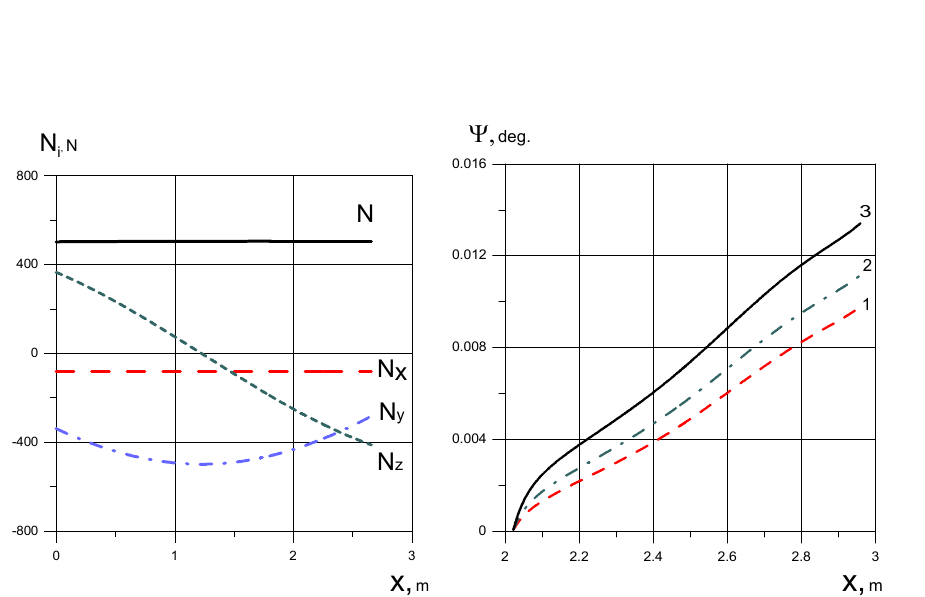
Figure 8 – Calculated values of the reaction force of the screw groove N and its projections on the axes of the starting coordinate system, as well as the yaw velocity angle Ψ along the length x of the spatial movement of the projectile at different elevation angles θ 0 of the tubular guide: 1 – θ 0 =19 0 4’; 2 – θ 0 = 33 0 36’; 3 – θ 0 =45 0